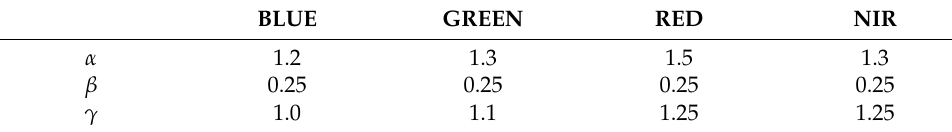
Table 2. β , γ band-dependent coefficients [-] used for SaSbEM